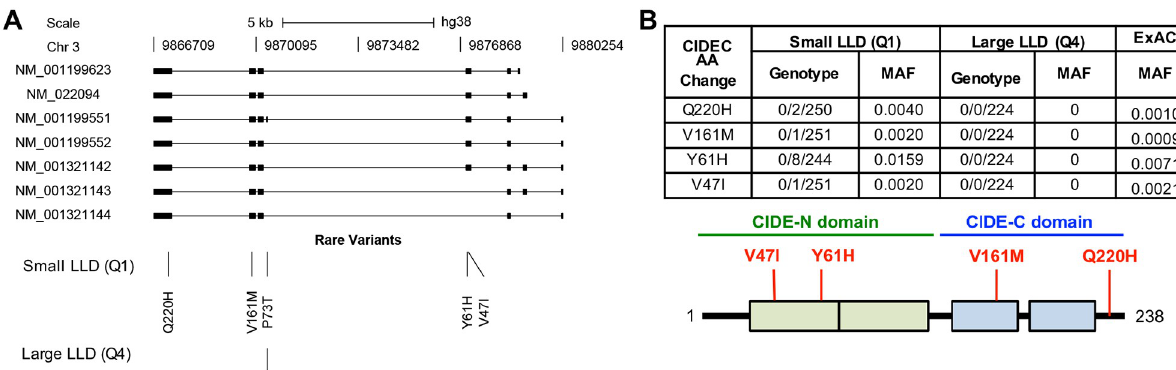
Fig 2. Genetic analysis of low-luminance deficit quartile Q1 and quartile Q4 AMD patients. (A) Genetic diagram of CIDEC and location of rare variants in Q1 and Q4 AMD patients. SNPs are indicated by amino acid change and position. (B) Table of genotype and minor allele frequencies for variants selected for further analysis and map of CIDEC protein with CIDE-N and CIDE-C domains with these SNPs annotated by position and amino acid change.